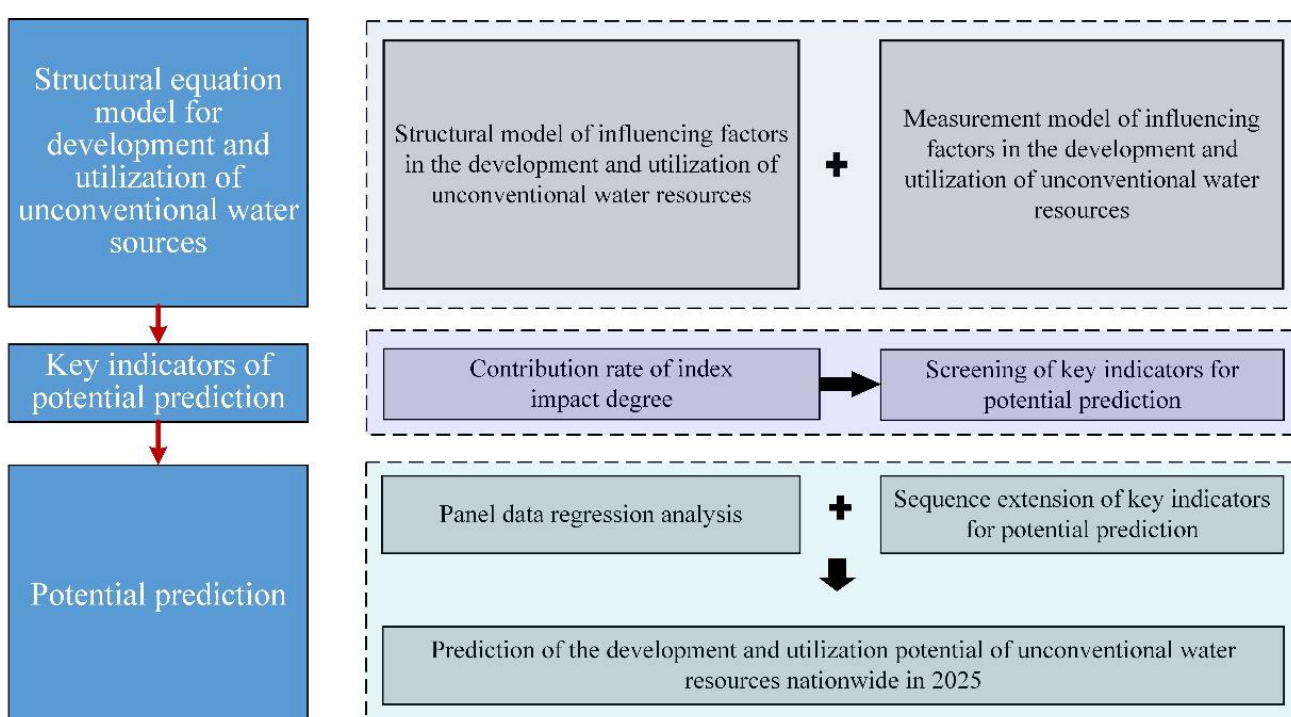
Figure 2. Workflow of prediction of the potential availability of reclaimed water.